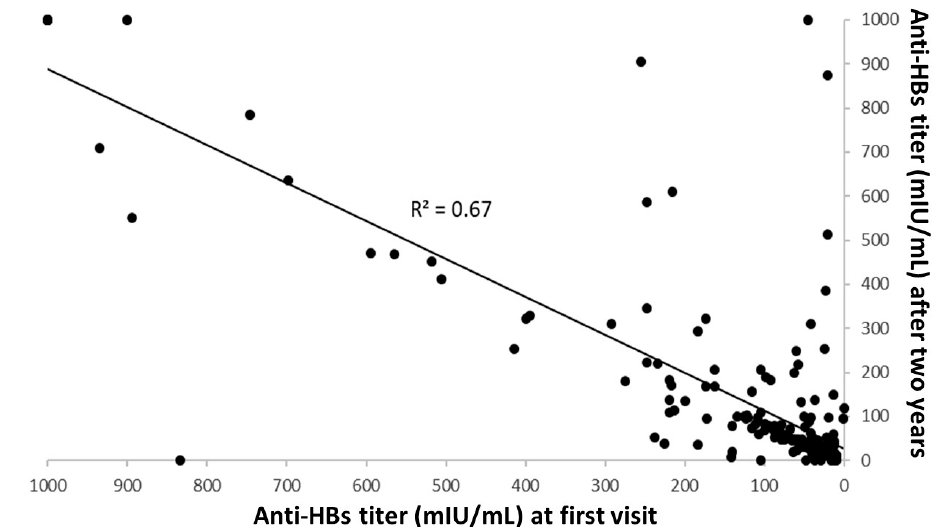
Figure 3. Correlation analysis between anti-HBs titers at first visit and at follow-up two years later (R 2 = 0.67; p < 0.001). (R 2 = 0.67; p <